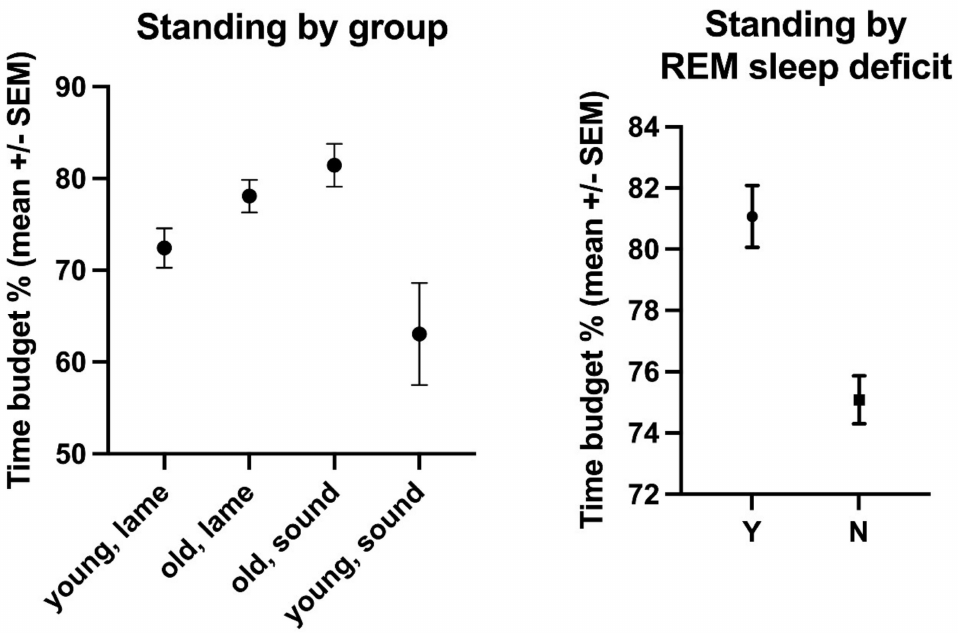
Figure 8. Comparative standing time budgets (mean % of 24 h +/ − SEM) of the horses enrolled in this study by age/lameness group and by the diagnosis of REM deficit (Yes (Y) and No (N)). Time of day significantly influenced standing time budgets ( p < 0.0001, Figure 9), but horse did not p =